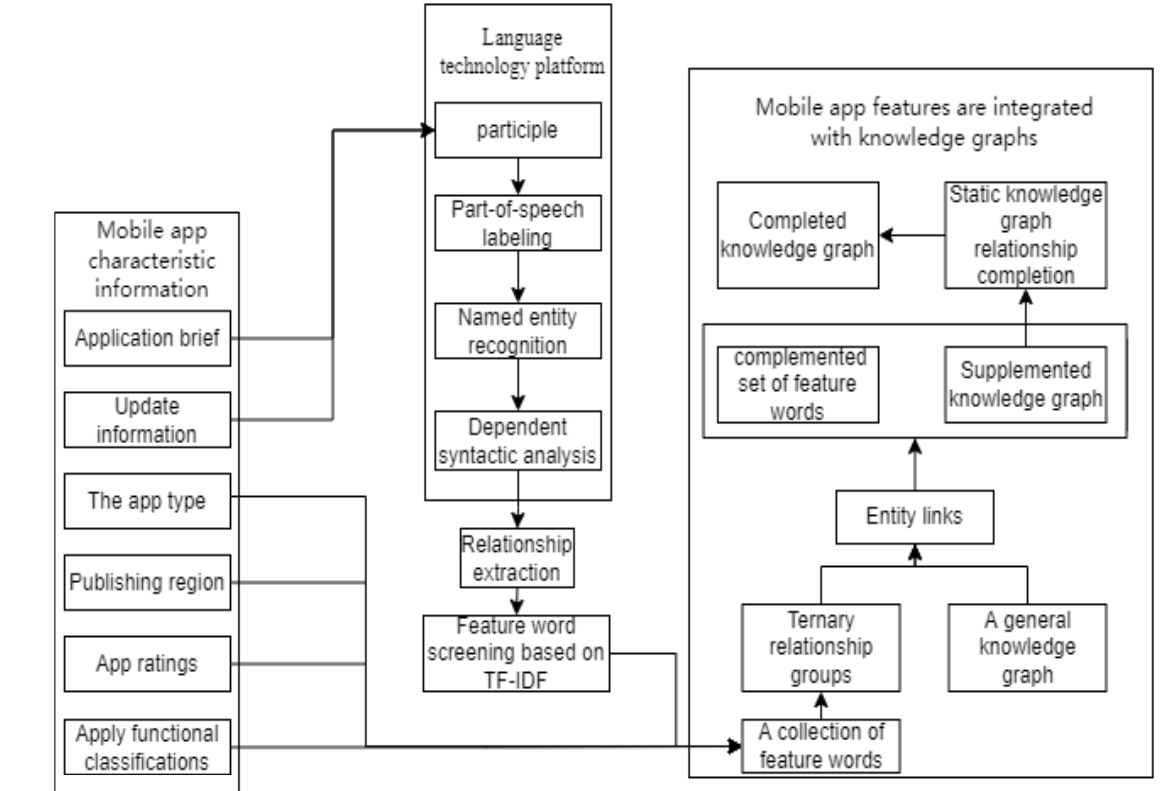
Figure 3. Application feature fusion flowchart based on knowledge graph.